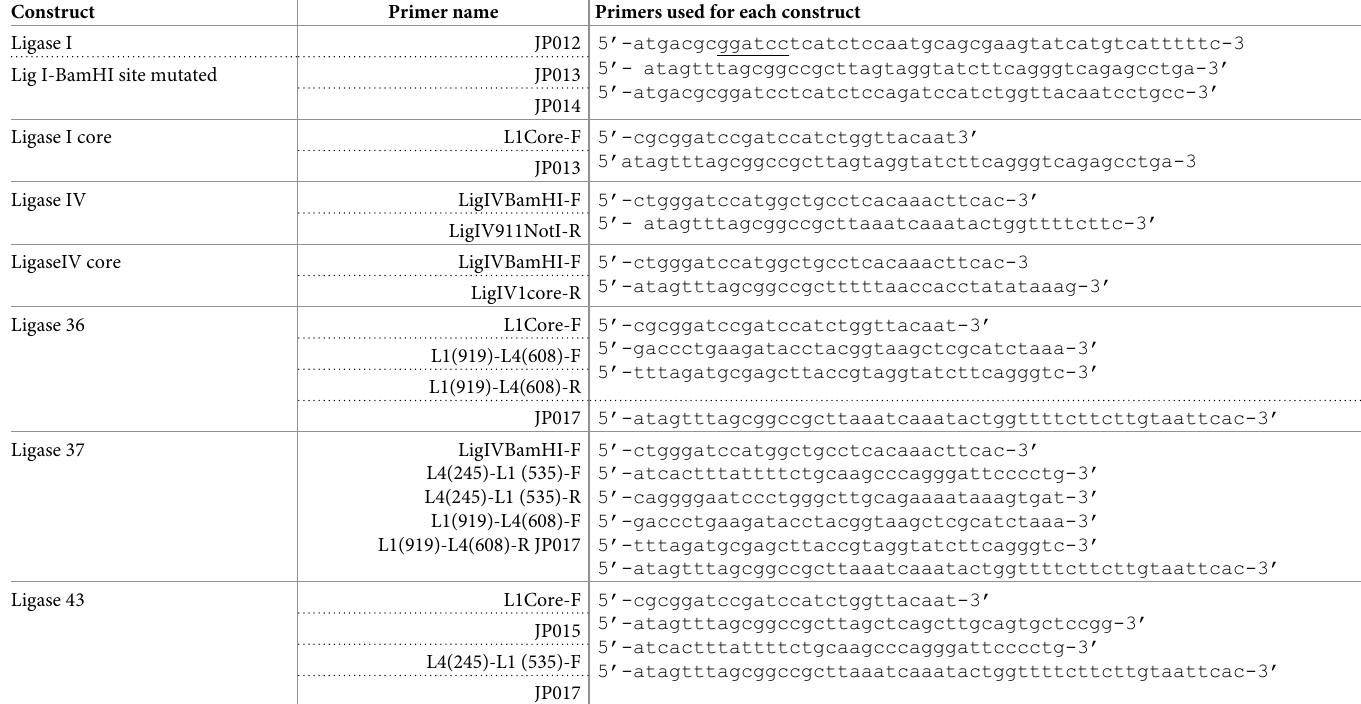
Table 1. PCR Primers used for generation of expression